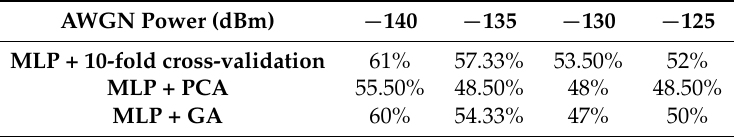
Table 13. ML-based prediction results for